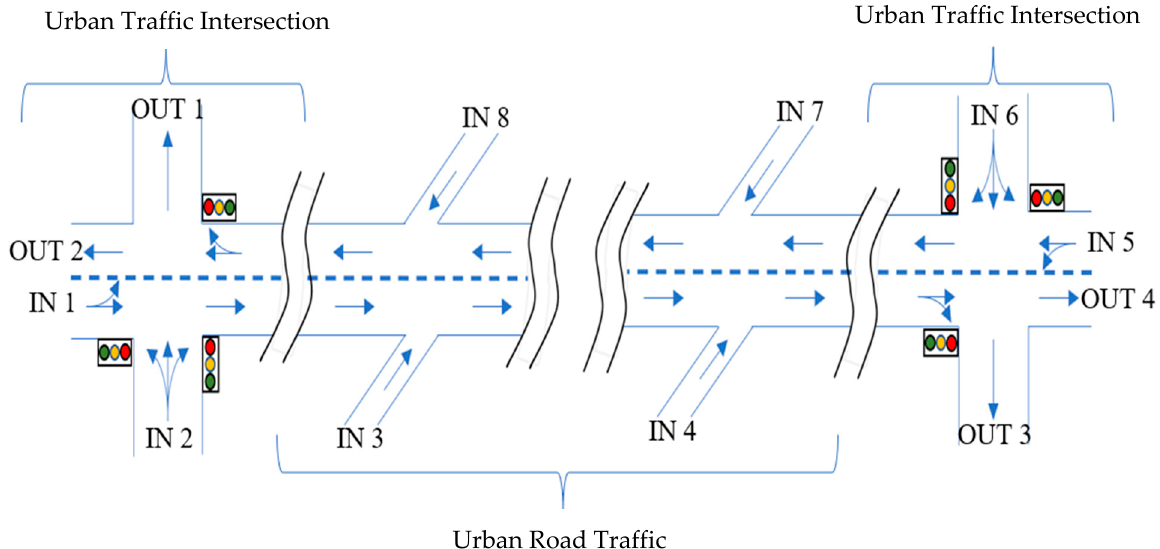
Figure 9. Urban area used in the evaluation of the hybrid model [68].